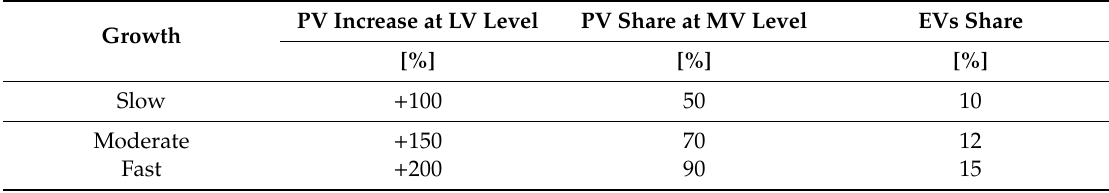
Table 4. Percentage of growth for